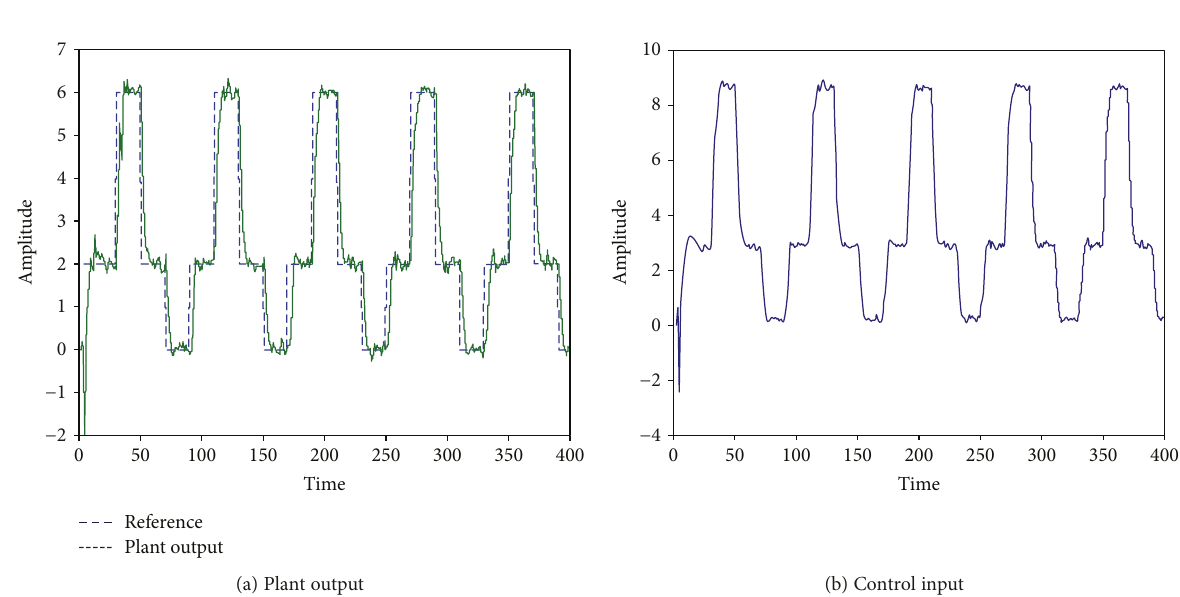
Figure 7: Plant output and control input.